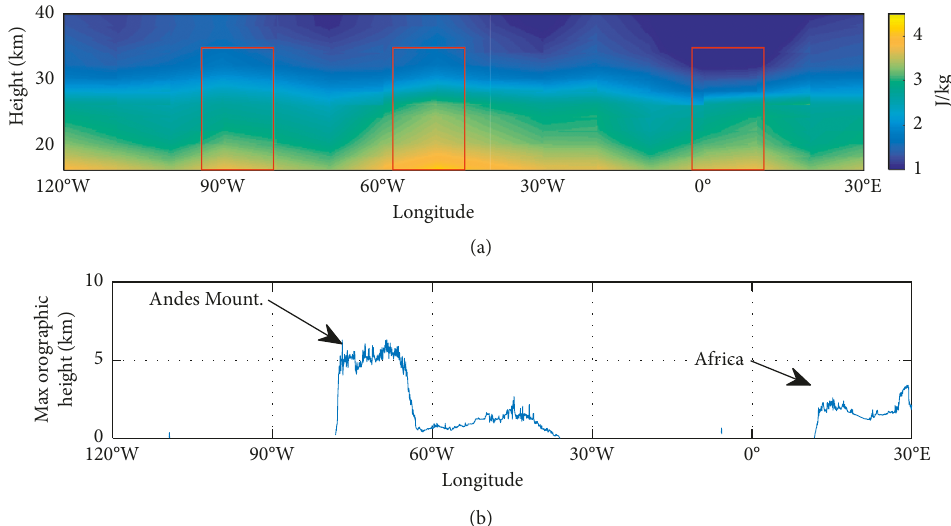
Figure 14: Zonal distribution of gravity wave potential energy at the latitude of 0 ° S–30 ° S in summer of the northern hemisphere (a) and maximum terrain height